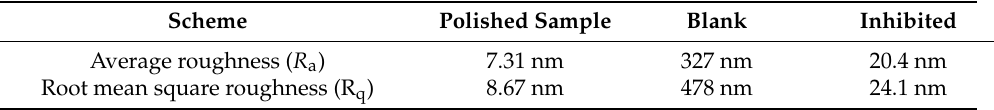
Figure 11. Water contact angle analysis: ( a ) polished MS, ( b ) after 6 h immersion in 1 M HCl, ( c ) after 6 h immersion in 1 M HCl + CMEA. The average roughness values and root mean square values were calculated with the help of nano scope analysis; 1.5 software was used. The inhibited MS sample exhibited the least average surface roughness of 20.4 nm, which was very low as compared to the blank as a consequence of the defensive film of CMEA formed on the MS.